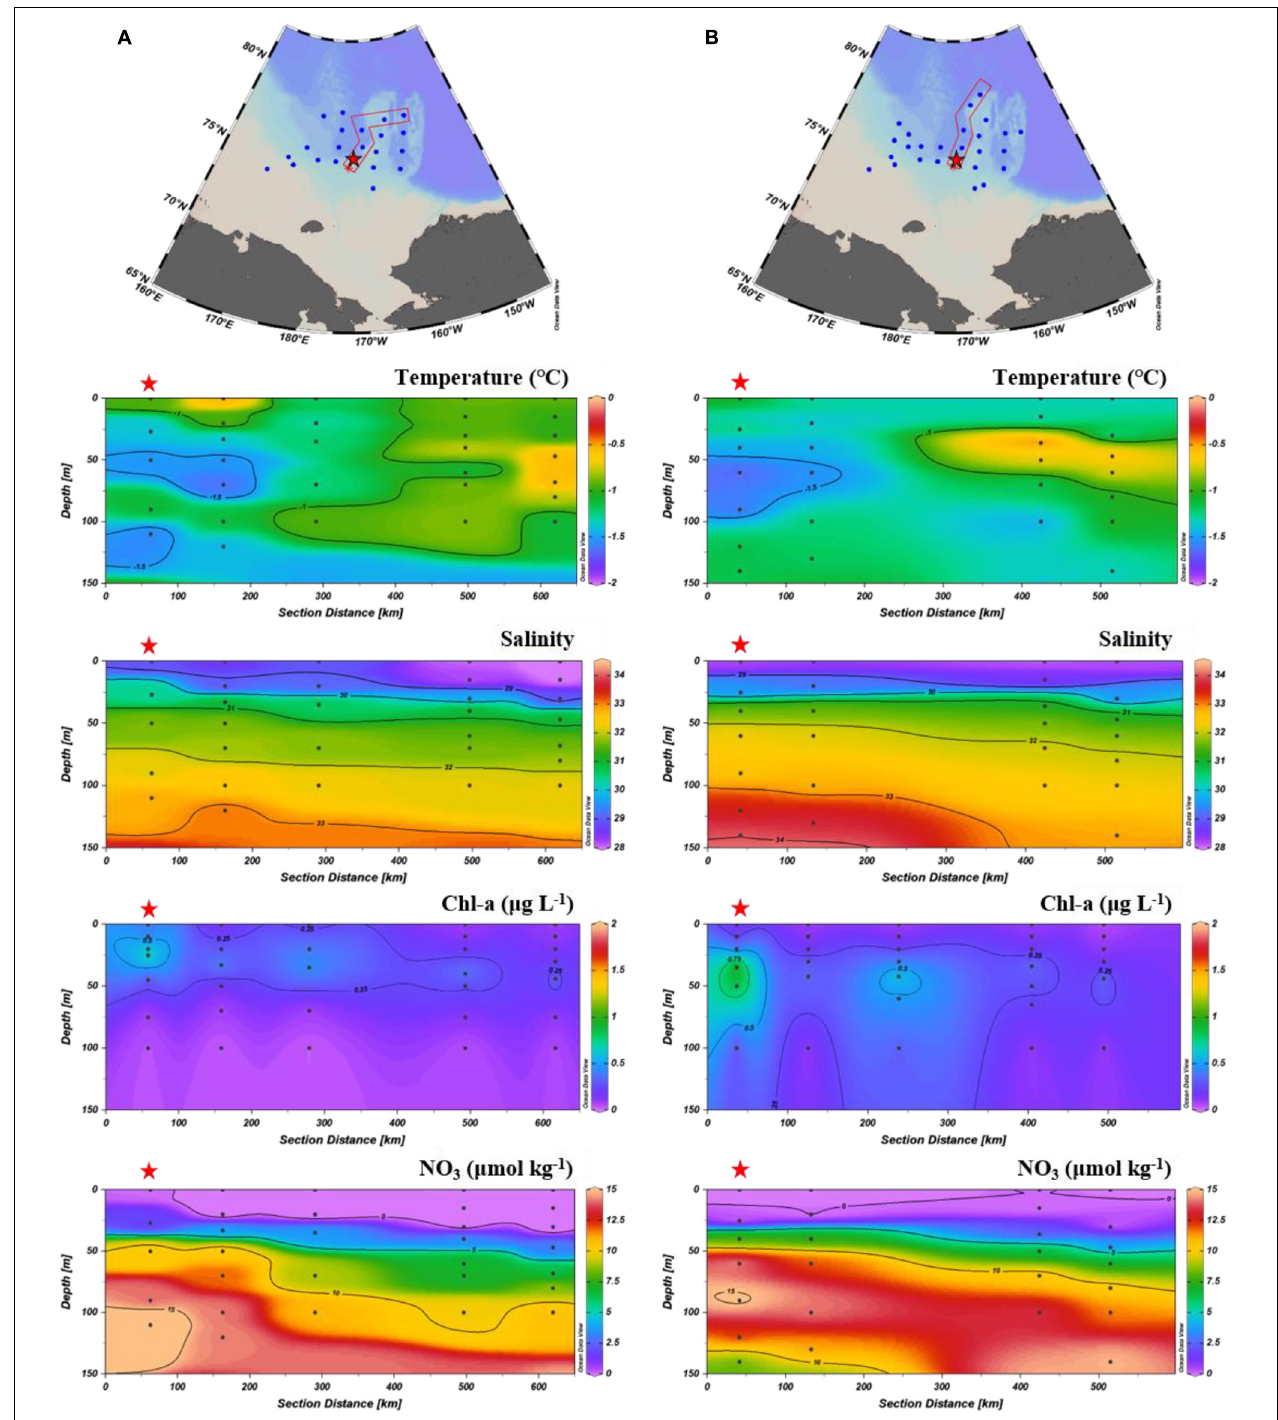
FIGURE 5 | Vertical distribution of temperature, salinity, chlorophyll- a , and nitrate along the transect on the Chukchi Sea slope (KAMS 2) in August 2017 (A) and August 2018 (B) . Red star indicates a sediment trap mooring site.